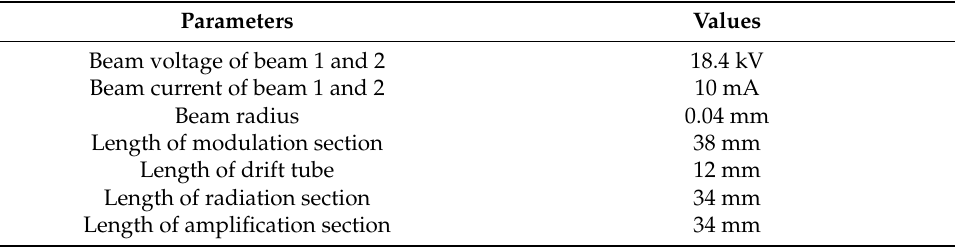
Figure 13. Power curve of the amplification section. Table 3. Parameters of the CE-HHTWT.